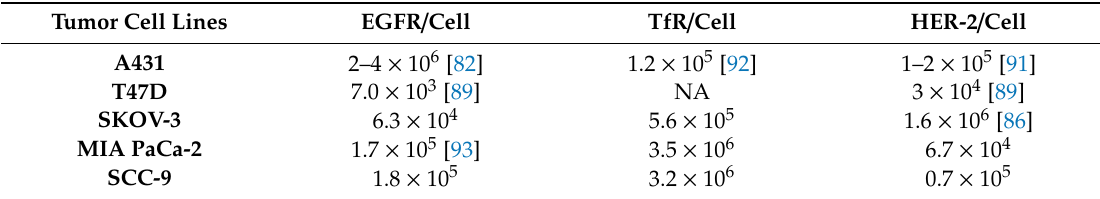
Table 2. Tumor-associated cell surface receptors (EGFR, HER-2, TfR) per